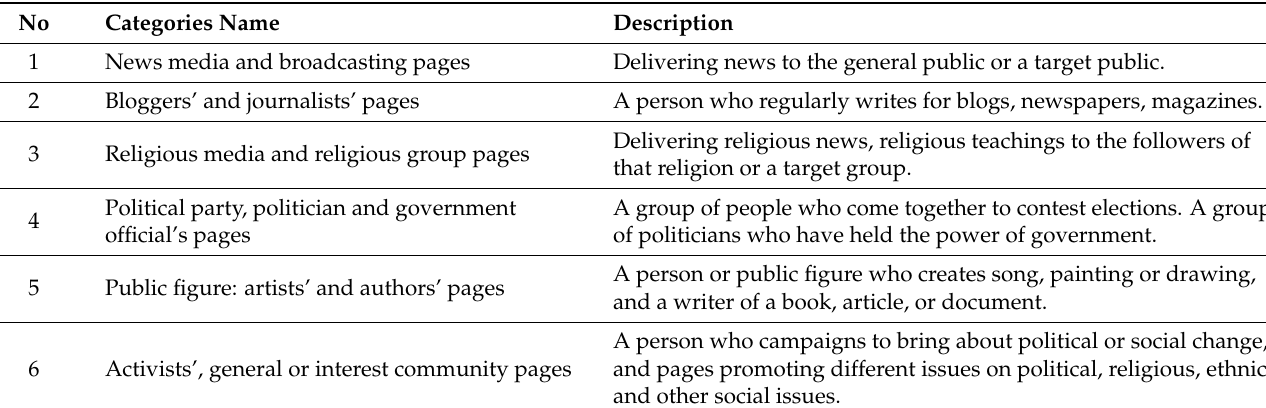
Table 2. Selected Social Media Page Categories.